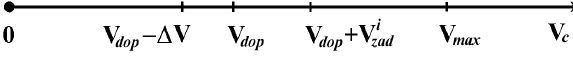
Figure 3: Scheme for determining the mode of car motion [own